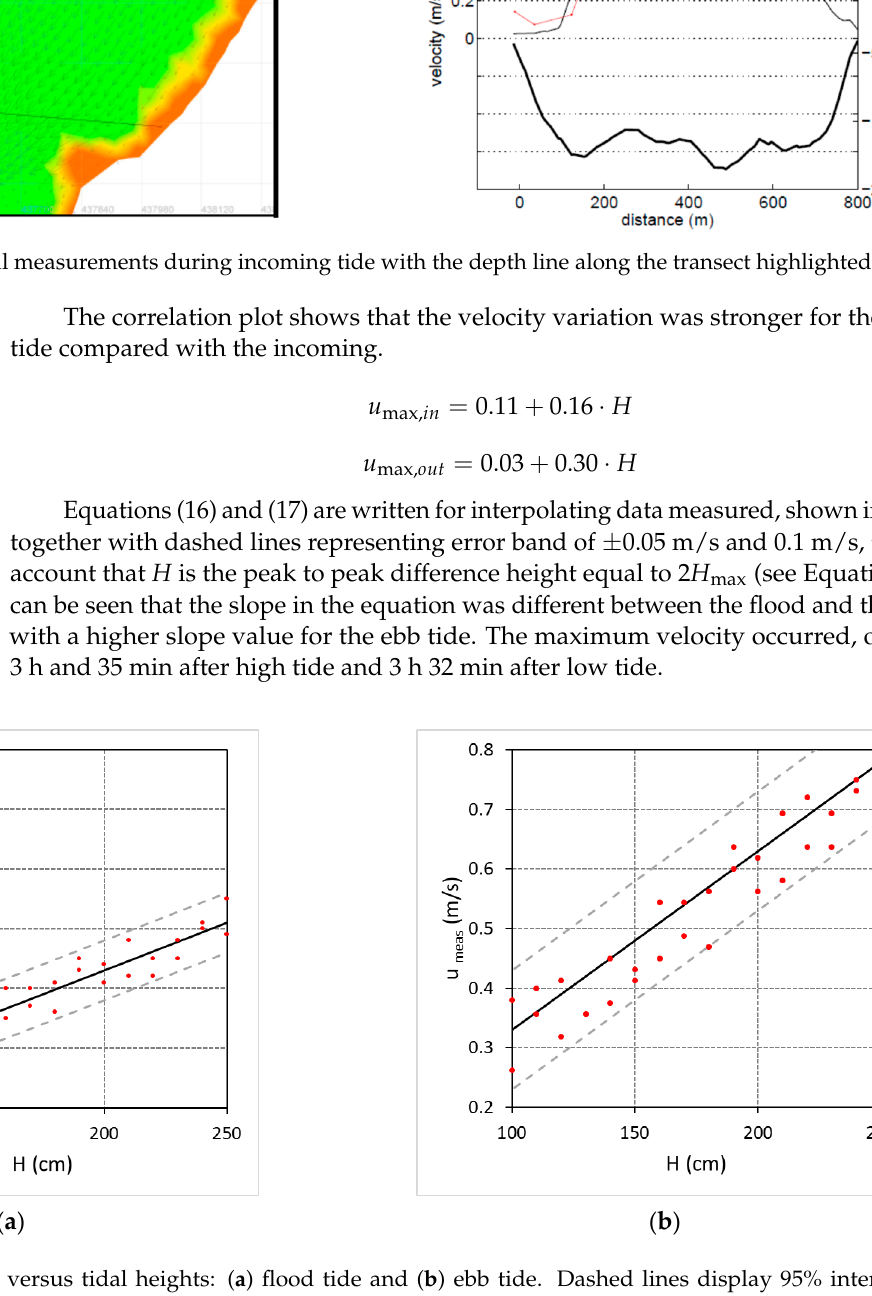
Figure 11. Velocity peaks versus tidal heights: ( a ) flood tide and ( b ) ebb tide. Dashed lines display 95% interval of confidence [31].